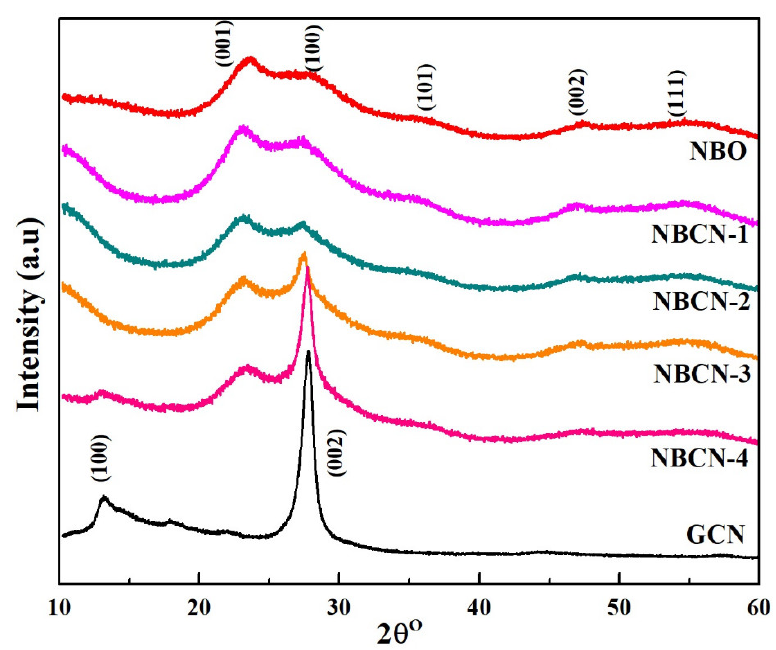
Figure 4. XRD patterns of NBO, g‐C 3 N 4 (GCN), NBCN‐1, NBCN‐2, NBCN‐3, and NBCN‐4.